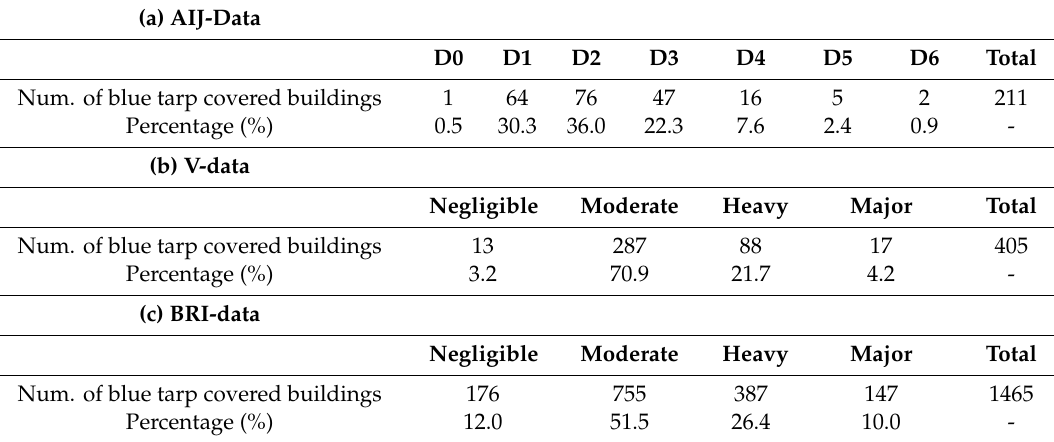
Table 3. Damage grades of extracted blue tarp covered buildings.